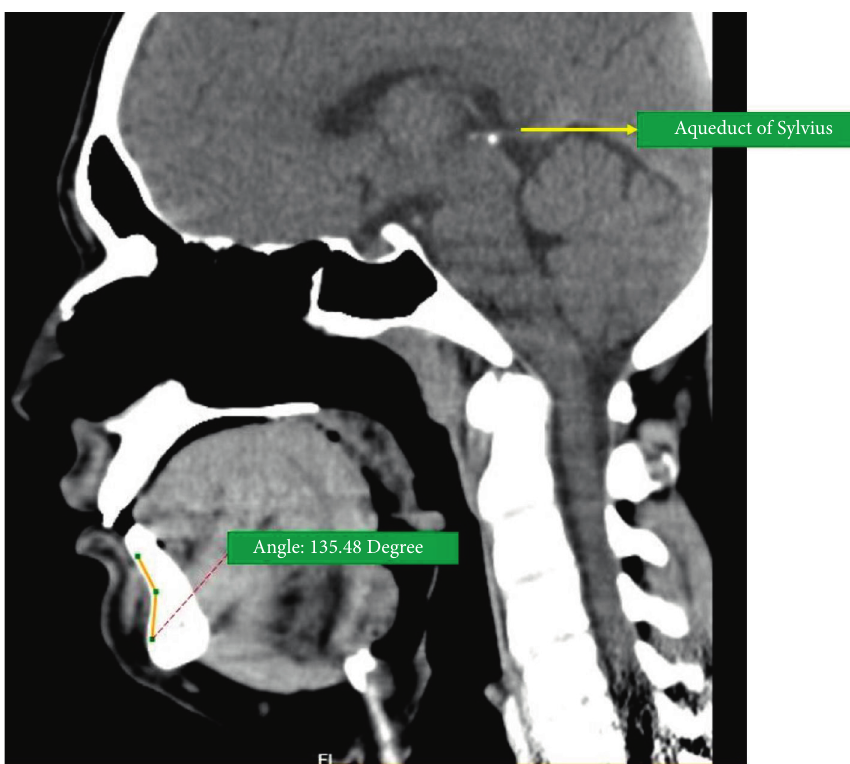
Figure 3: Chin angle in a 2D CT scan of a noncondylar fracture